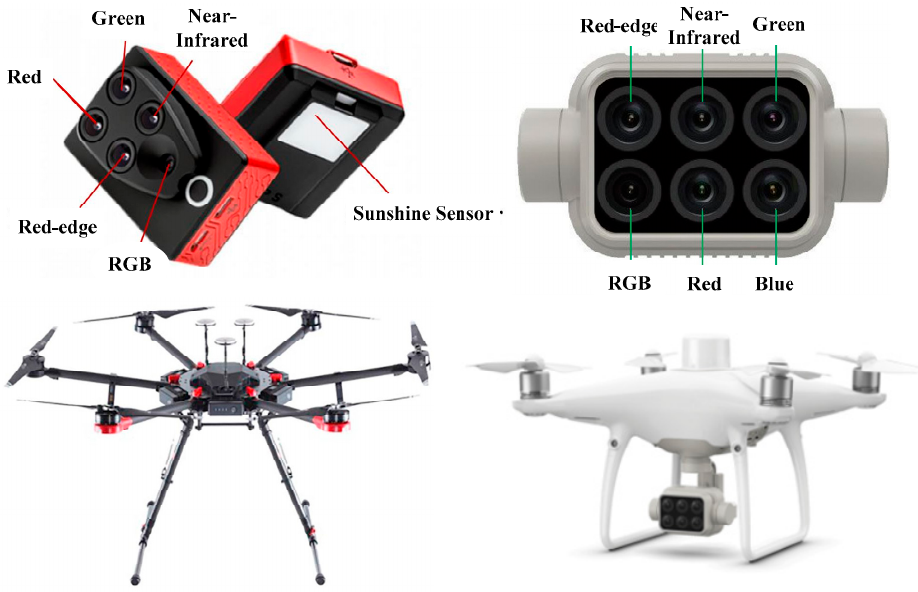
Table 1. Spectral band information for the Parrot Sequoia (Sequoia) and DJI Phantom 4 Multispectral (P4M). Their approximately equivalent bands (green, red, red edge, and near-infrared) were compared in this study.